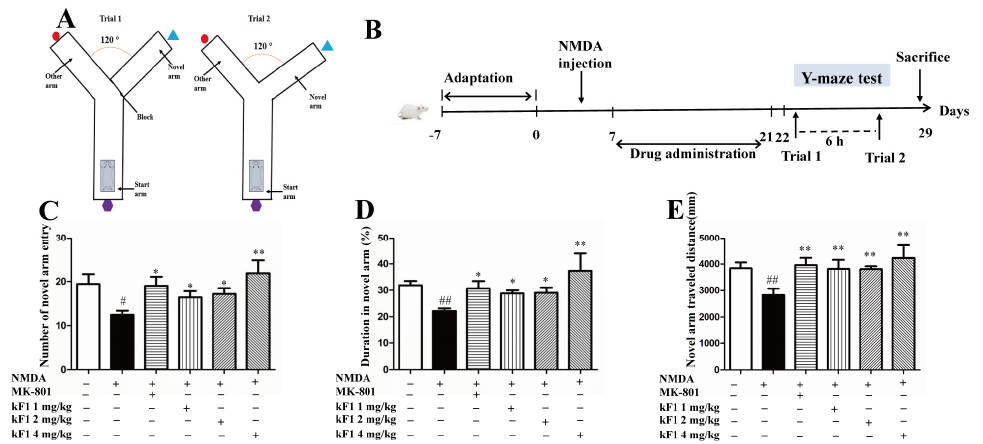
Figure 4. Effect of KF1 on spatial memory in the Y-maze test. ( A ) The two-trial Y-maze apparatus. ( B ) Experimental procedure. ( C ) The novel arm region of exploration numbers. ( D ) The novel arm region of total duration rate. ( E ) The novel arm region of travel distance. All data represent the mean ± SEM. # p < 0.05, ## p < 0.01 versus vehicle group; * p < 0.05, ** p < 0.01 versus NMDA group (each group, n =10-12).